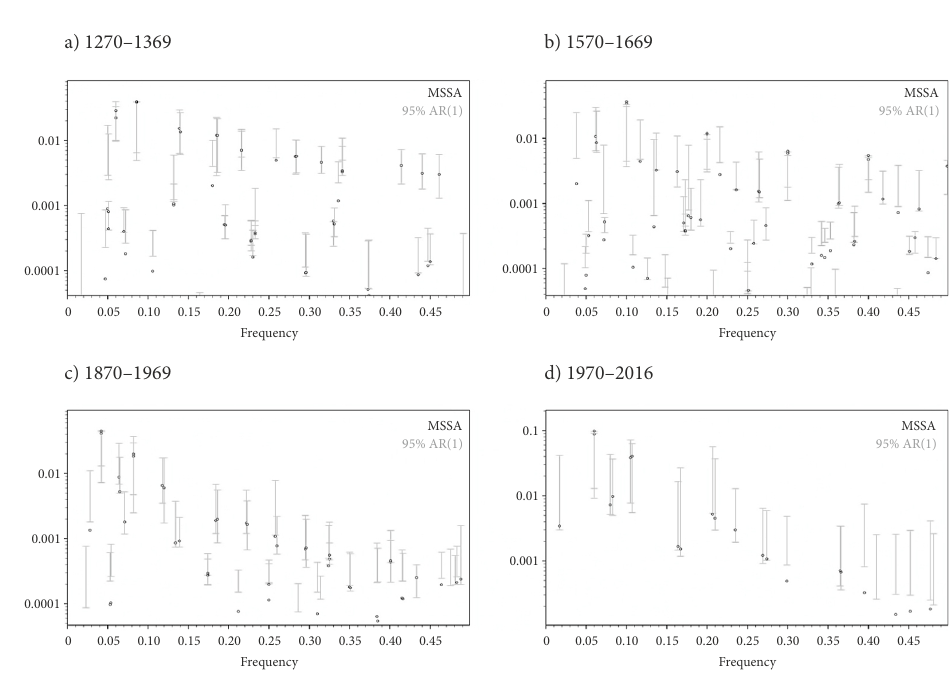
Figure 3. Isolated financial cycles frequencies in the UK 1270–2016 (source: Authors’